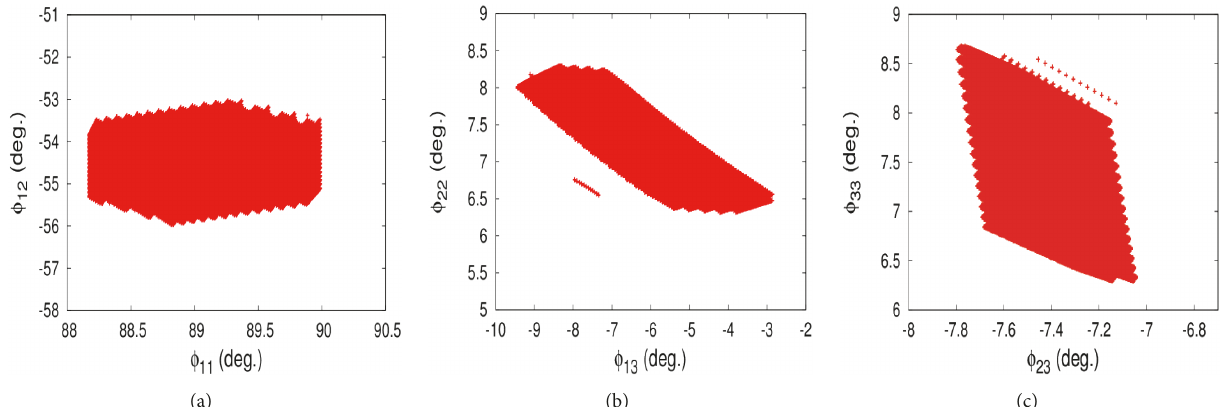
Figure 6: Determination of phases of 𝑌 matrix elements for fixed value of lightest mass eigenvalue 𝑚 1 = 0.001 eV. Phase angles used for computation are the same as in Figure 5. Neutrino oscillation observables are varied within 1𝜎 range; (a) variation of 𝜙 11 with 𝜙 12 , (b) 𝜙 13 versus 𝜙 22 , and (c) 𝜙 23 versus 𝜙 33